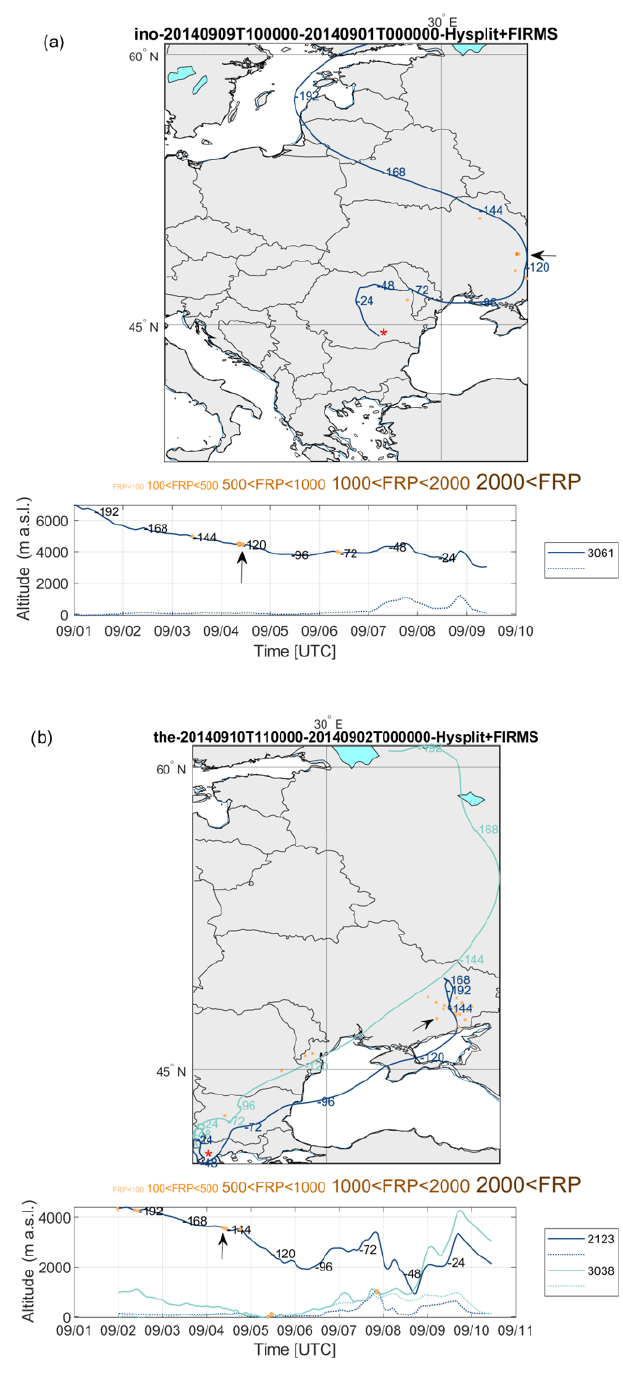
Figure 8. Back trajectories and locations of fires along back trajec- tories within 100km and ± 1h for Bucharest (“ino”) on 9 Septem- ber 2014 (a) and Thessaloniki (“the”) on 10 September 2014 (b) . Lower plots show the altitude (a.s.l.) of the back trajectories versus time. The common fire location is marked with an arrow. See text for more